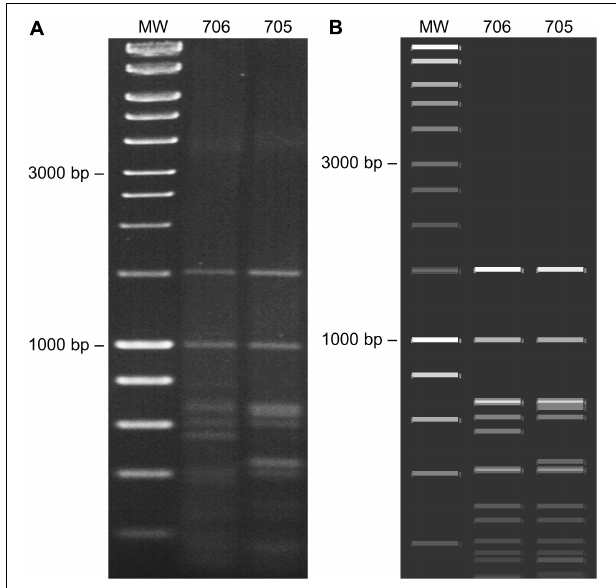
FIGURE 4 | Restriction fragment length polymorphism (RFLP) analysis of begomoviruses and deltasatellites infecting Corchorus siliquosus (samples 705 and 706). (A) RFLP performed by digestion of rolling circle amplification (RCA) products obtained from DNA extracts with the restriction enzyme Hpa